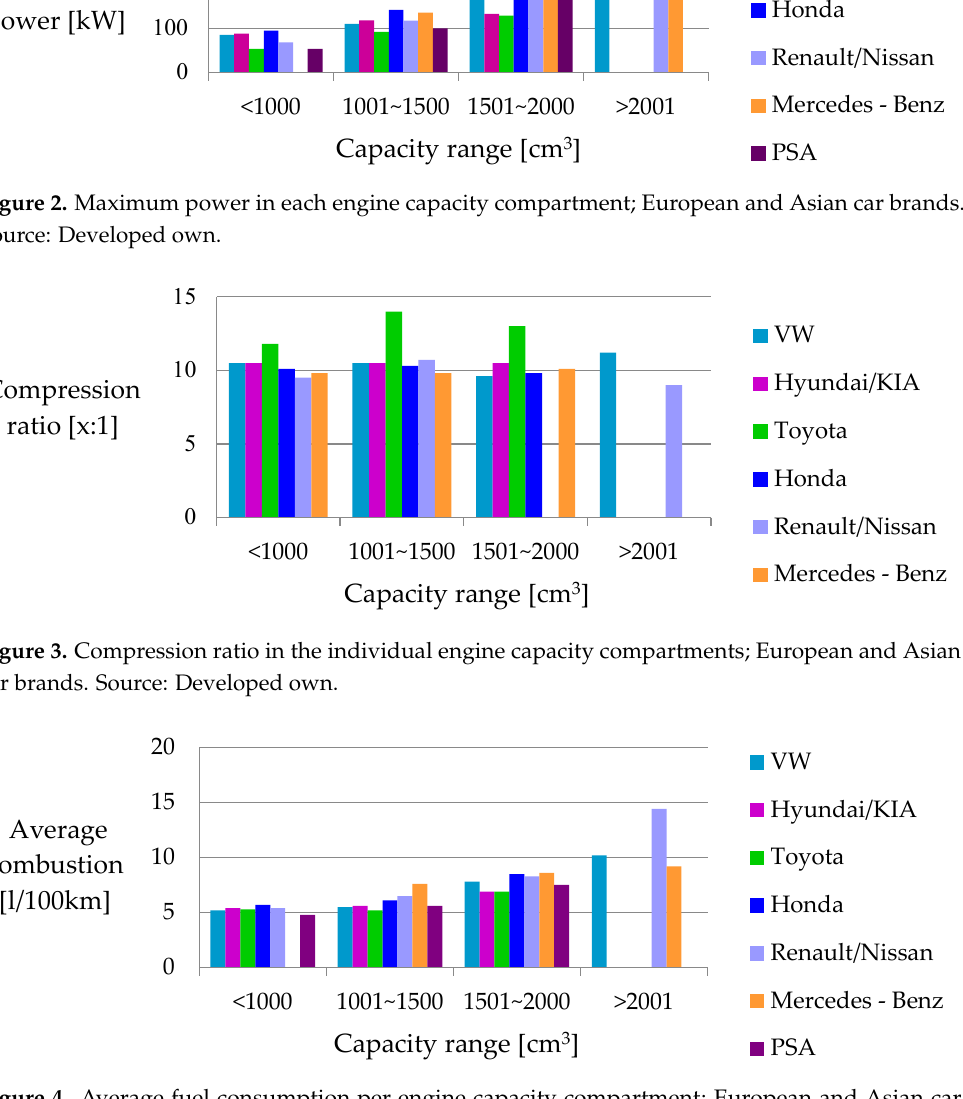
Figure 4. Average fuel consumption per engine capacity compartment; European and Asian car brands. Source: Developed own. Figure 5. Engine power per liter of displacement in the different engine displacement compartments; European and Asian car brands. Source: Developed own.